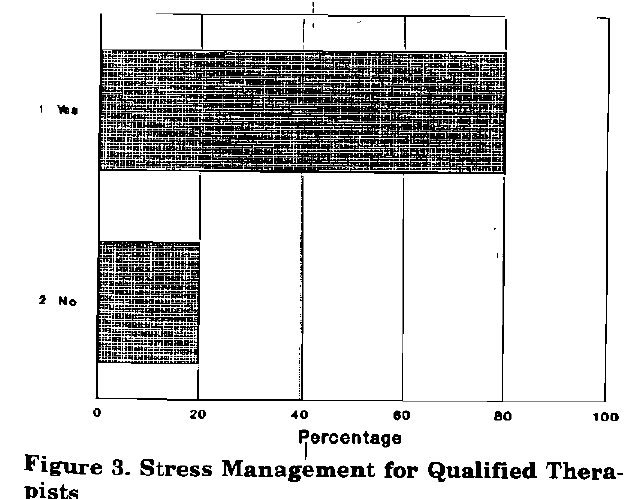
Figure 3. Stress Management for Qualified Thera-